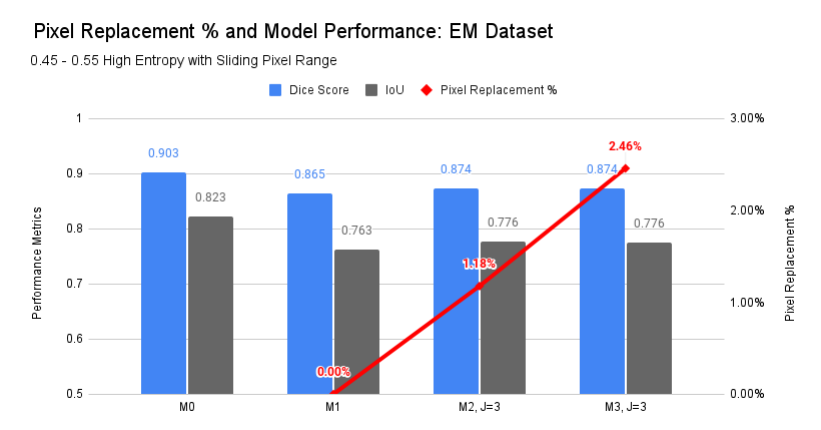
Figure 3. Performance on the EM dataset using the SSPA approach with HE pixel label replacements.